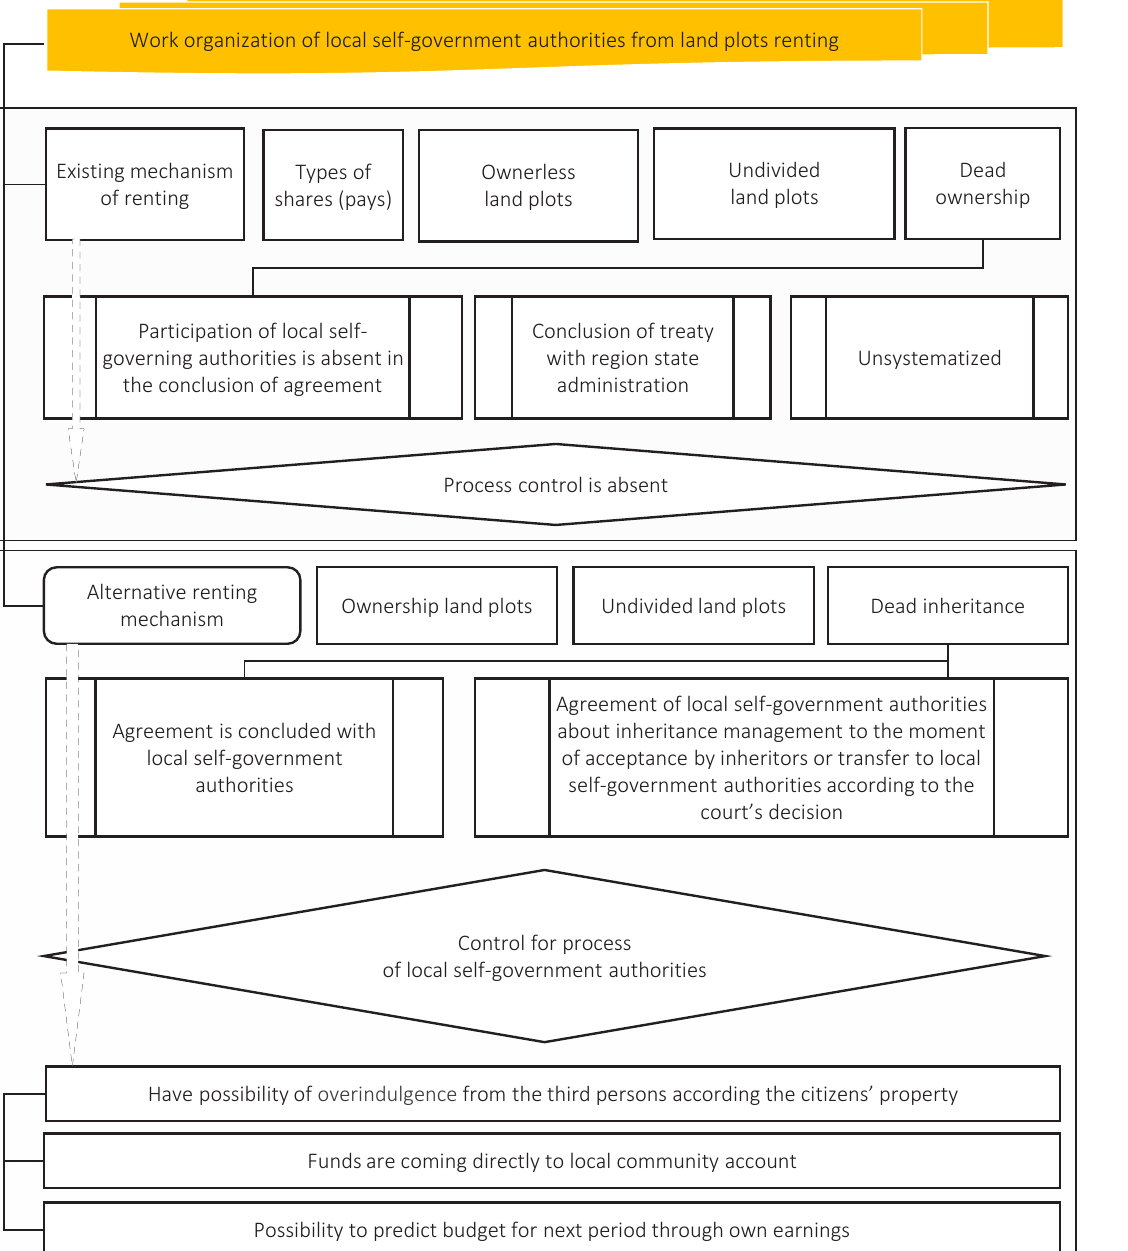
Figure 6. Steps of the process of the land plots (pays)